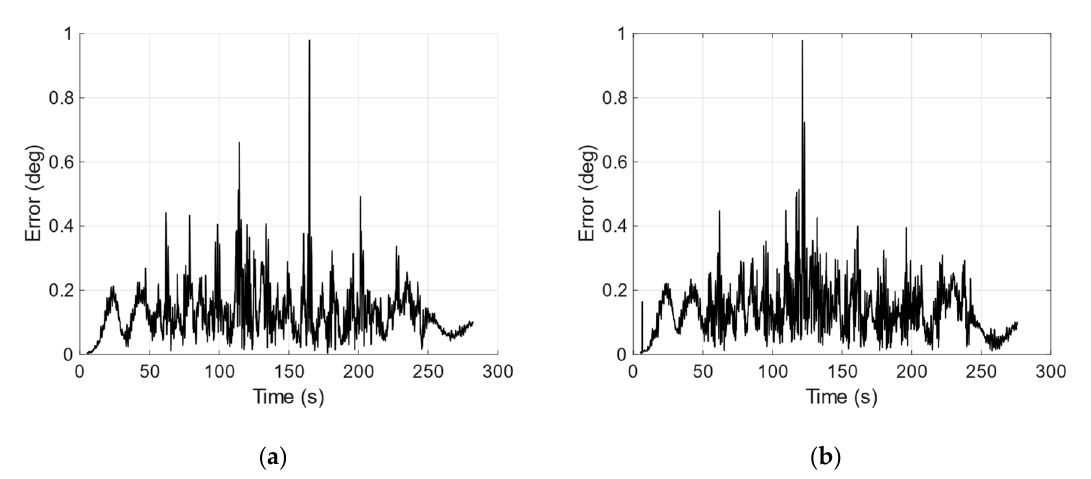
Figure 13. Checkerboard target mounted on top of the Ideal Aerosmith 2102C turntable, for verification of the monocular vision system.